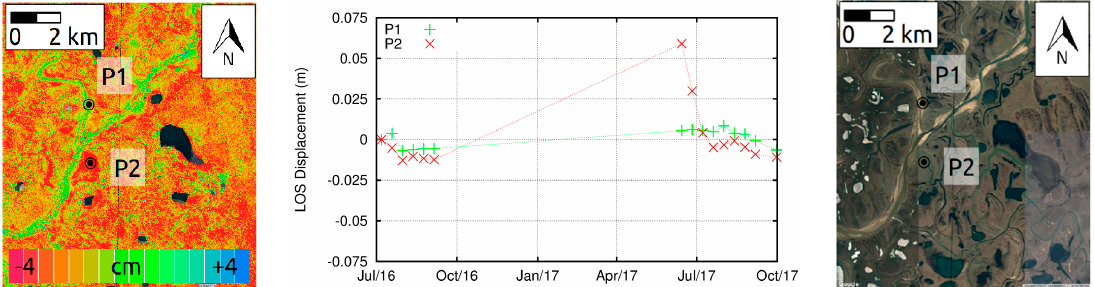
Figure 3. Time series of displacement in the line ‐ of ‐ sight direction over a floodplain area (P1) and within the Arctic peaty silty riverine ecological landscape of the Ikpikpuk River Delta (P2) within the Teshekpuk Lake site. For location see Figure 2. Map data are from Google, DigitalGlobe. Remote Sens. 2018 , 10 , x FOR PEER REVIEW